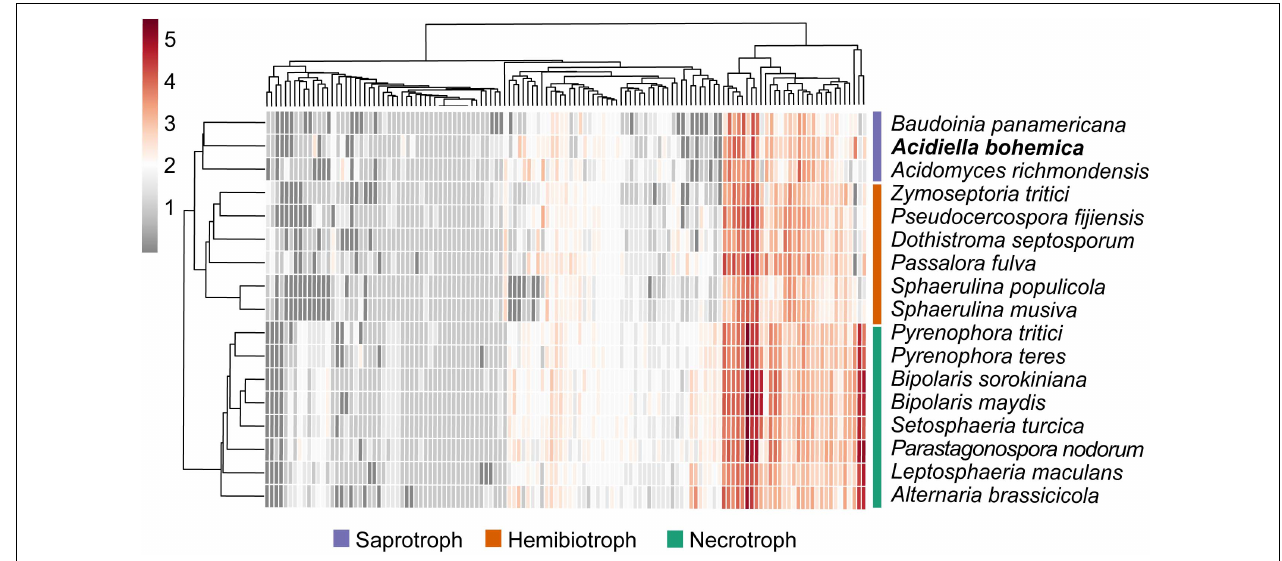
FIGURE 4 | Heat map of CAZyme families in the Dothideomycetes . Both the CAZyme families and the species are hierarchically clustered. The clustering of organisms largely follows the phylogeny. The hemibiotrophs (orange) and saprotrophs (purple) within the Capnodiales cluster together, and the necrotrophs (green) within the Hysteriales and Pleosporales cluster